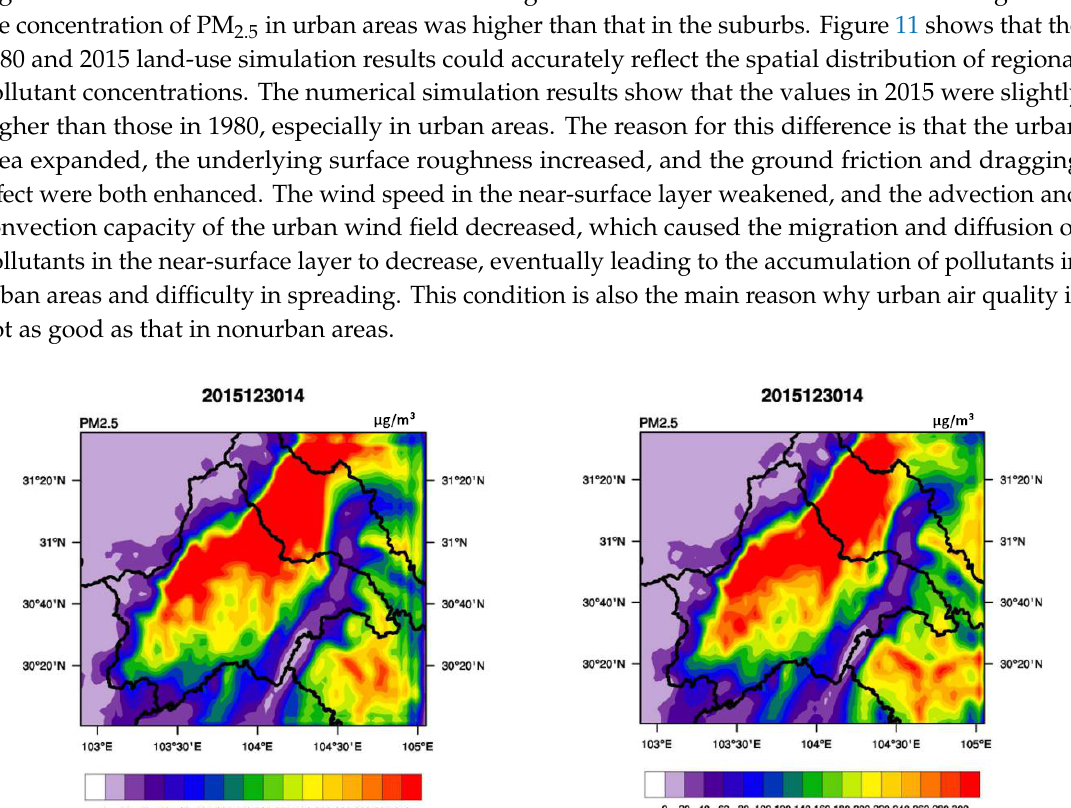
Table 13. Analysis of PM 2.5 concentration simulation results using 1980 and 2015 land-use data. Time R Bias (%)